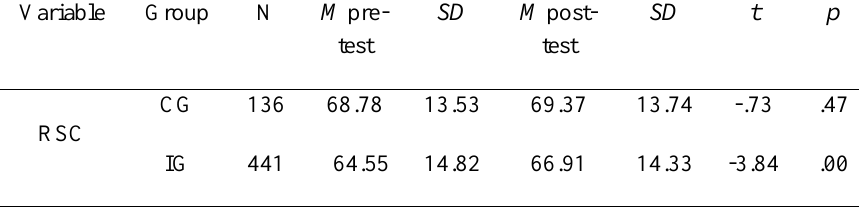
Reading Self-Concept (RSC) pre-test and post-test results in CG and IG